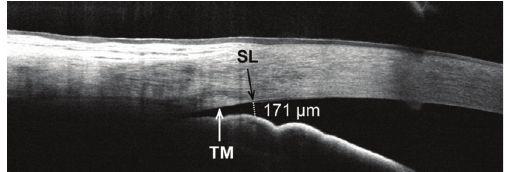
Figure 4: Frame-averaged cross-sectional OCT image of the nasal angle in an eye with primary narrow angle glaucoma. The AOD-SL (dotted line) was measured at 177 ¯m, below the diagnostic cuto ff value of 230–290 µ m, indicating a potentially occluded angle. This agreed with a gonioscopic grade of 1 on the modified Sha ff er scale. The trabecular meshwork (TM) and Schwalbe’s line (SL) can be distinguished.